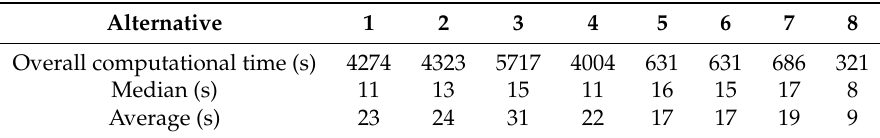
Table 3. Details of computational time for each